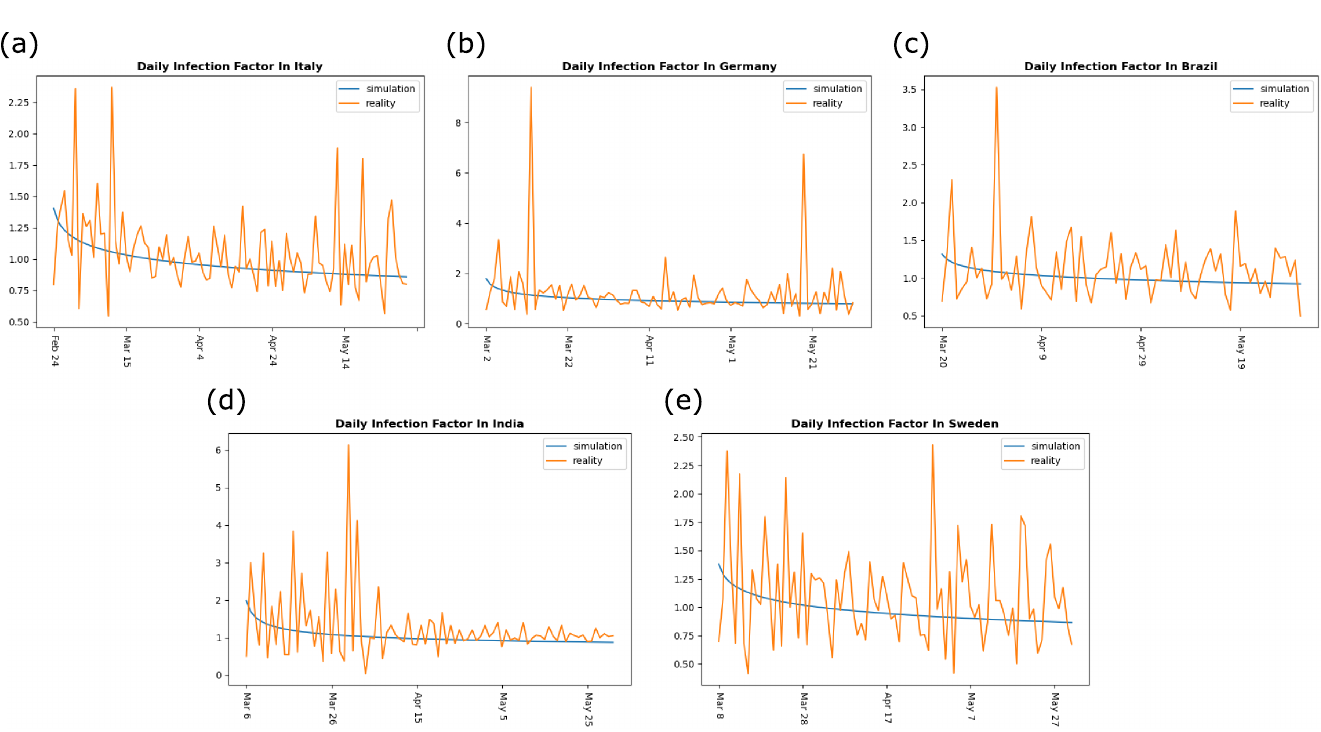
Fig 1. Daily infection factor. (a) daily infection factor change in Italy since February 23, 2020, (b) daily infection factor change in Germany since March 1, 2020, (c) daily infection factor change in Brazil since March 19, 2020, (d) daily infection factor change in India since March 5, 2020, and (e) daily infection factor change in Sweden since March 7, 2020. The orange curve describes the infection factor in the real world, and the blue curve is the simulated infection factor obtained through regression analysis.